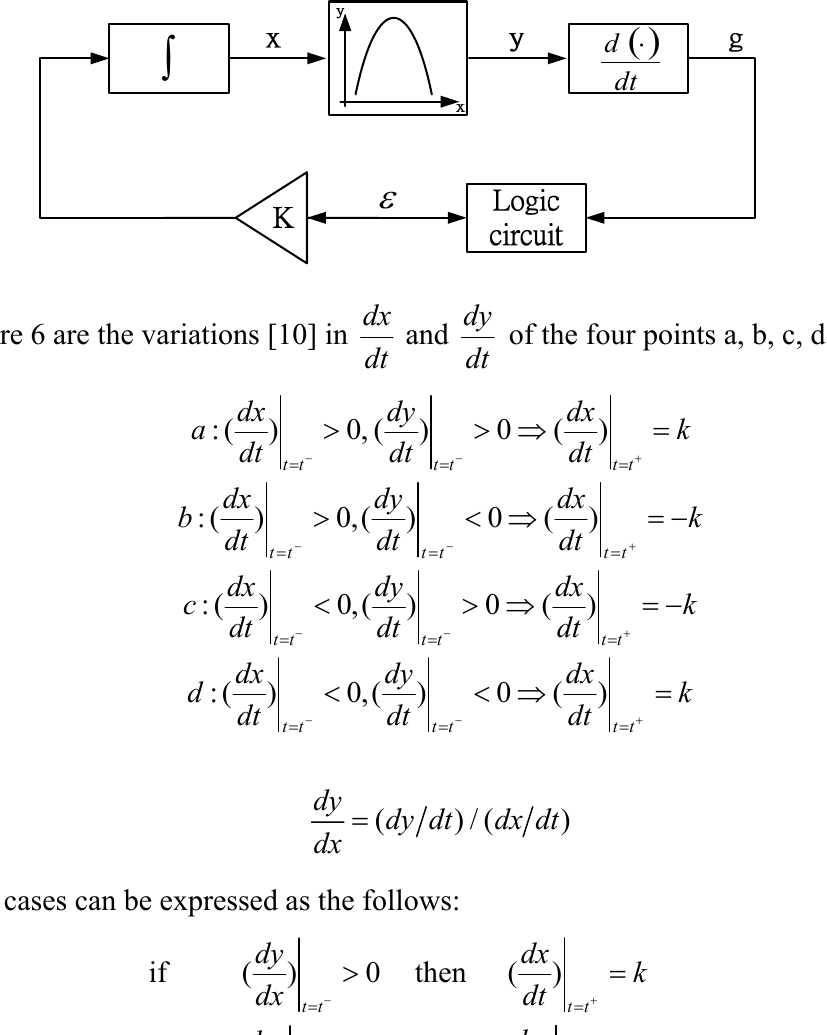
Figure 5. A block diagram of an ESC control